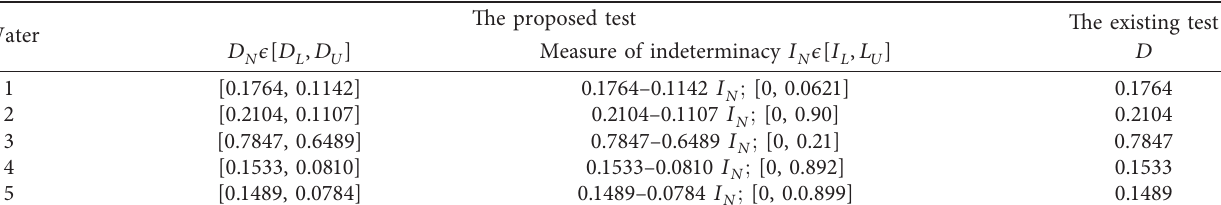
Table 4: The comparison of two tests.